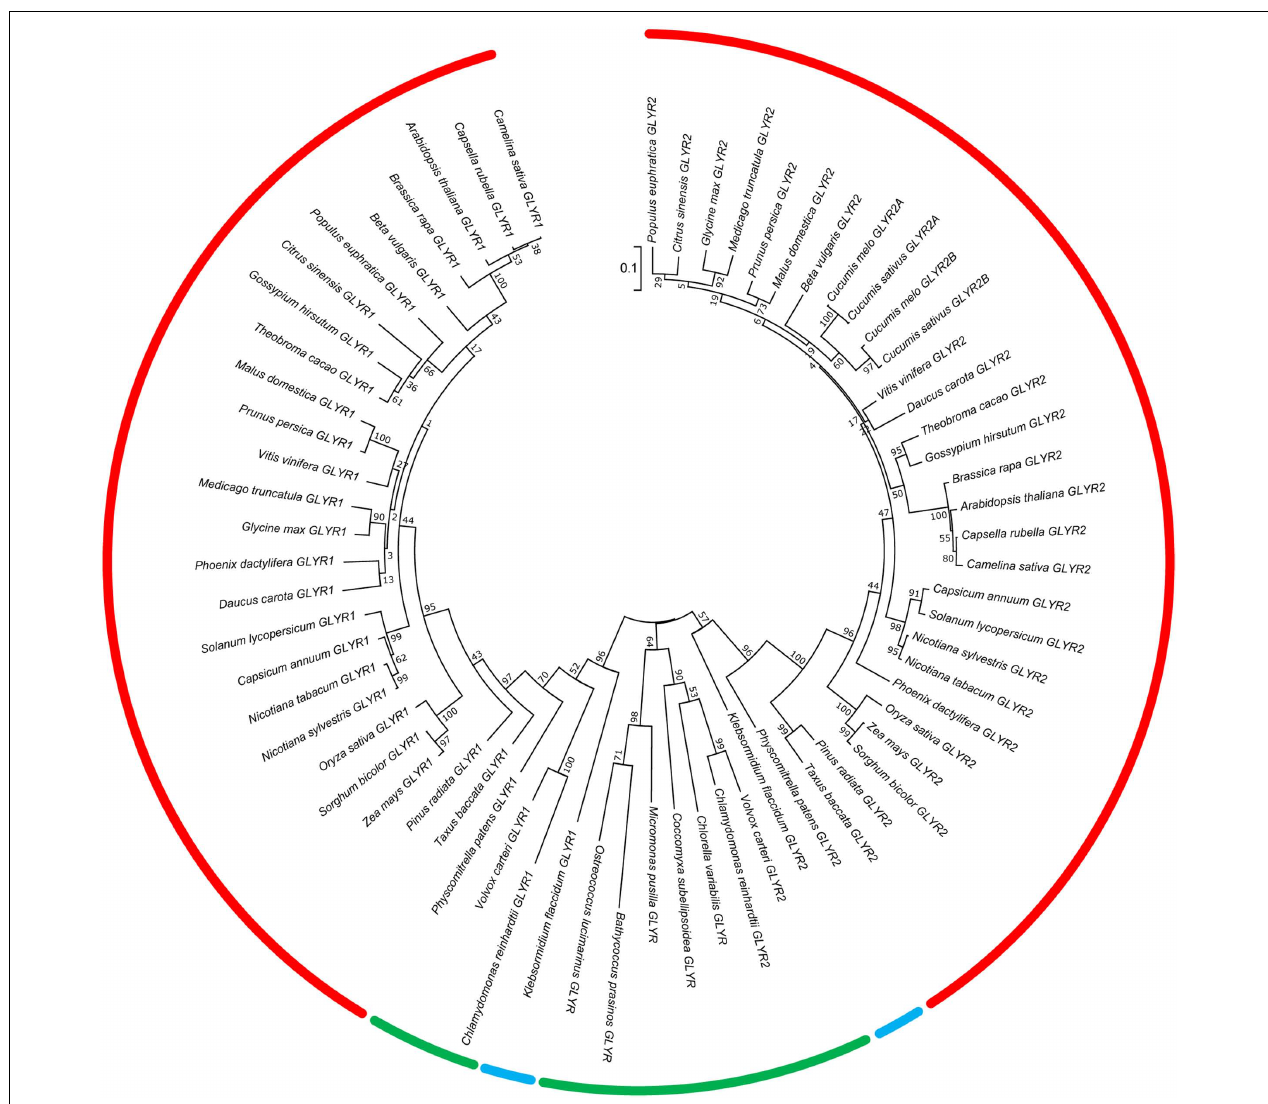
FIGURE 1 | Phylogenetic analysis of plant GLYR amino acid sequences across plant species. The unrooted phylogenetic tree was depicted using the Maximum Likelihood method in MEGA7. The red, blue, and green bars represent species in the Embryophyta, Charophyta, and Chlorophyta, respectively. The numbers at each node represent support values obtained by a bootstrap test using 1000 replicates (Felsenstein, 1985). The tree is drawn to scale (0.1 representing a 10% change) with branch lengths in the same units as those of the evolutionary distances used to infer the phylogenetic tree. The protein IDs for the GLYR1s and GLYR2s are given in Supplementary Tables S1,